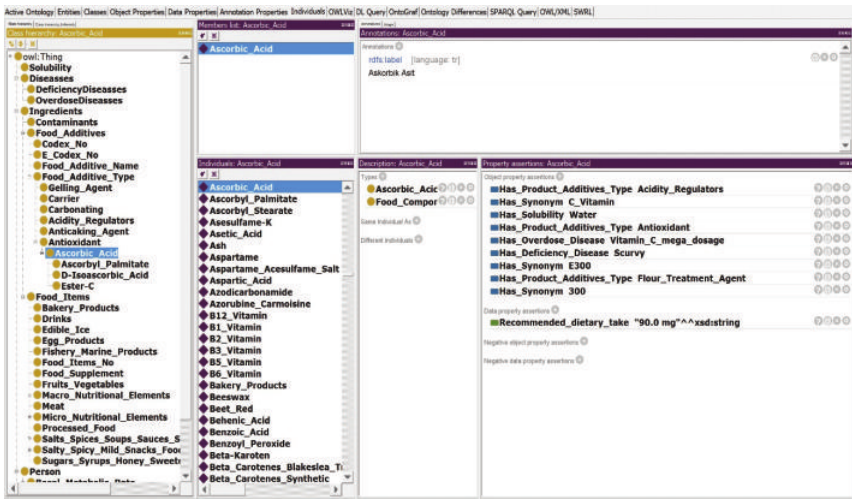
Figure 1: A small portion of the Food Ontology Knowledge Base (FOKB) on the Prot´eg´e ontology